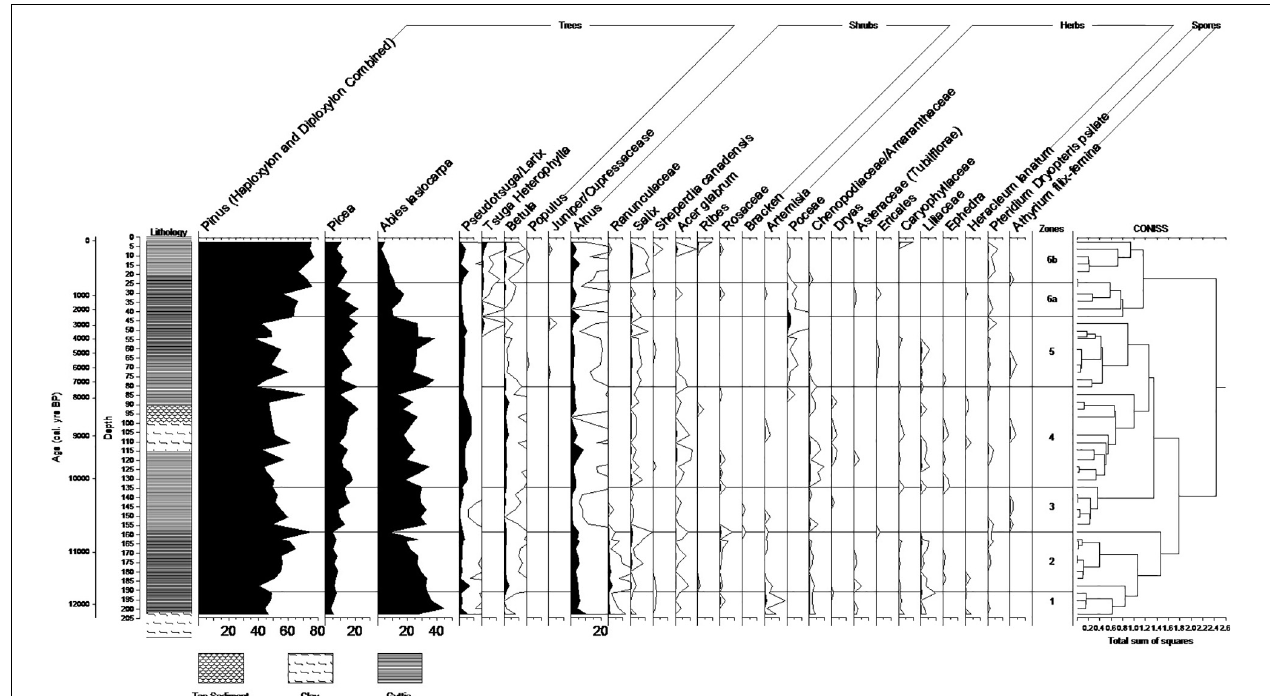
FIGURE 3 | Percent pollen diagram for Marion Lake, BC, including age depth, lithology, and constrained cluster analysis for zonation. Hollow lines represent 10X exaggeration of pollen percentages.